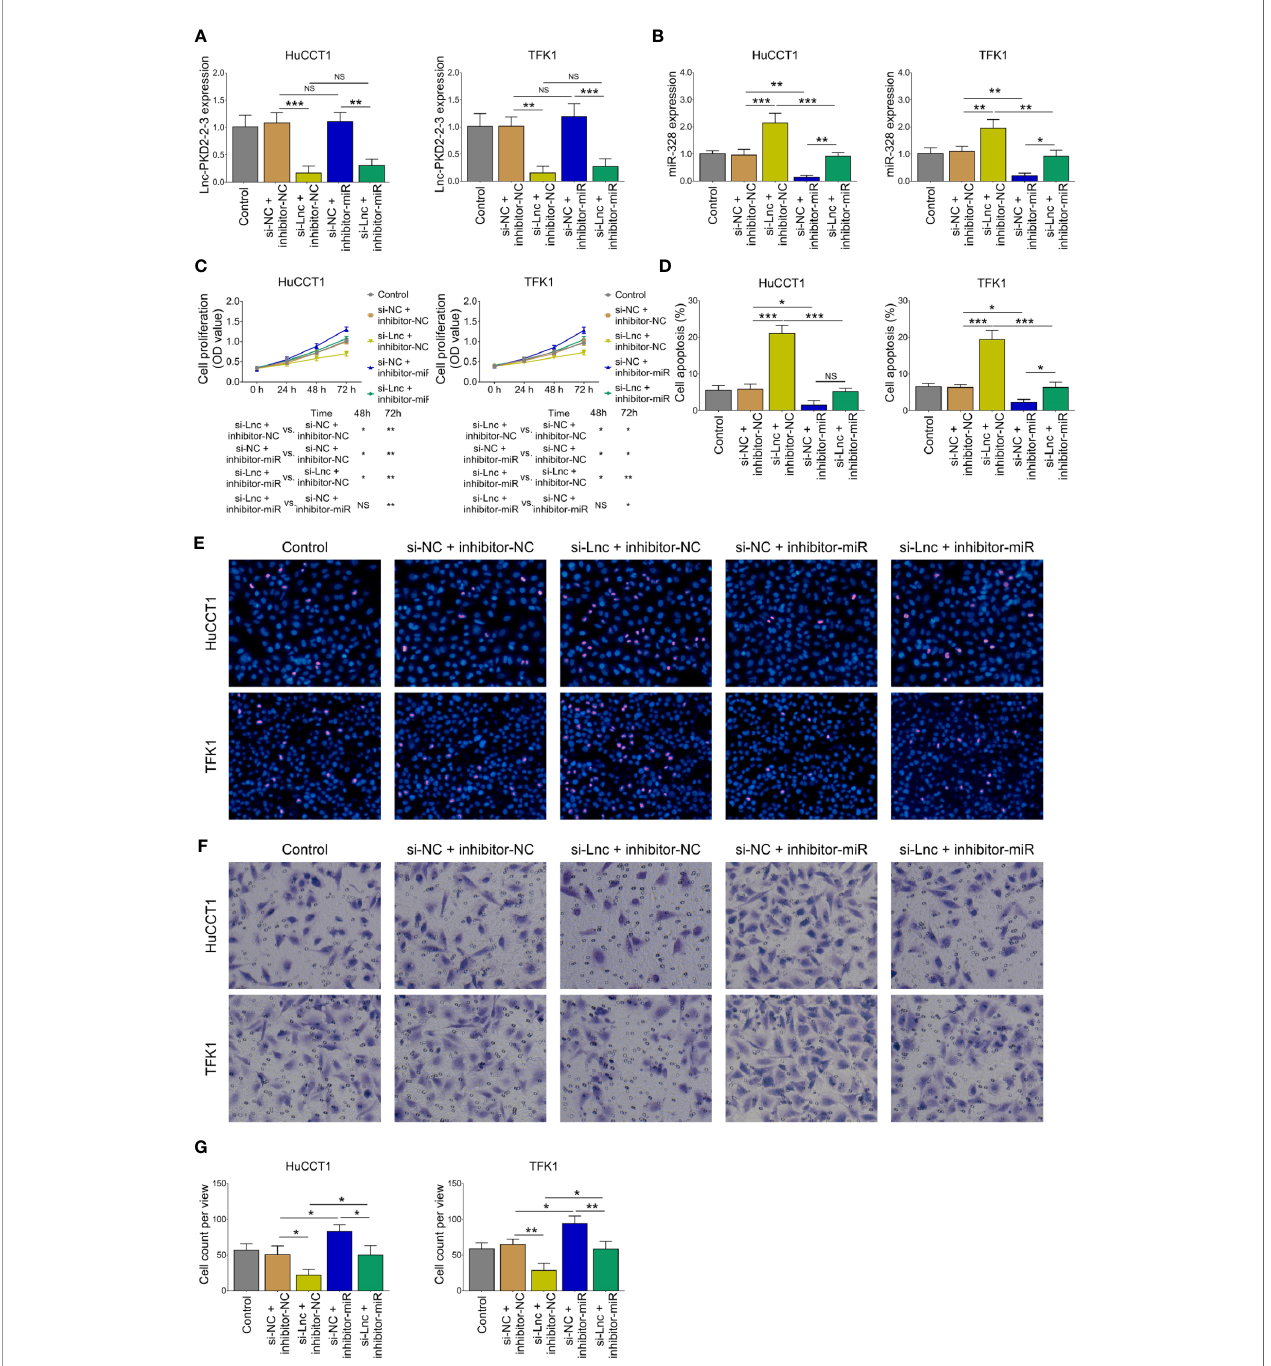
FIGURE 4 | Effect of miR-328 knockdown on cell proliferation, apoptosis, and invasion in CCA cell lines. Lnc-PKD2-2-3 expression (A) , miR-328 expression (B) , cell proliferation (C) , cell apoptosis rate (D) , TUNEL image examples (E) , Transwell image examples (F) , and invasive cell count (G) among groups after transfection. NS, not signi fi cant; * P < 0.05; ** P < 0.01; *** P <